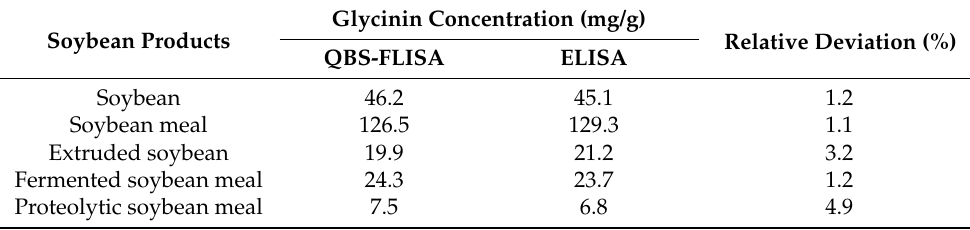
Table 4. The QBs-FLISA and ELISA results of different soybean products ( n = 6).